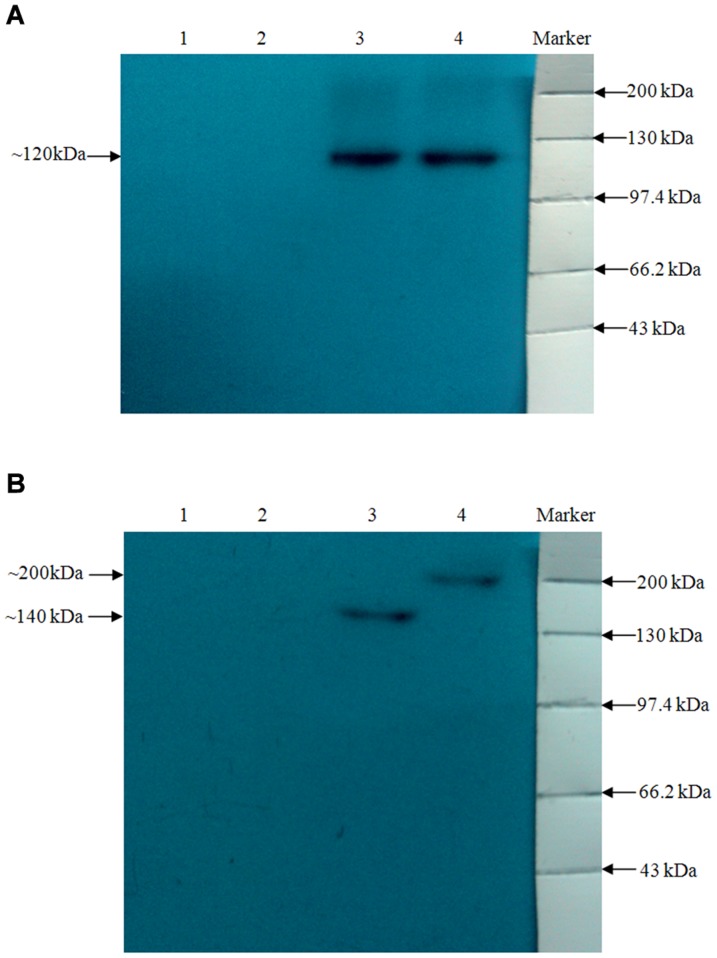
Western blot of cells transfected with recombinant plasmids.BHK-21 cells were transfected with pIRES-(TGEV-S1-PEDV-S1) or pIRES-(TGEV-S1-PEDV-S). Transient expression of proteins within the transfected cells was detected by Western blot with anti-TGEV antibodies (Panel A) and anti-PEDV antibody (Panel B), respectively. Panel A; (1): cell control; (2): pIRES vector control. (3): Cells transfected with pIRES-(TGEV-S1-PEDV-S1) and (4): Cells transfected with pIRES-(TGEV-S1-PEDV-S). Panel B; (1): cell control; (2): pIRES vector control. (3): Cells transfected with pIRES-(TGEV-S1-PEDV-S1) and (4): Cells transfected with pIRES-(TGEV-S1-PEDV-S).